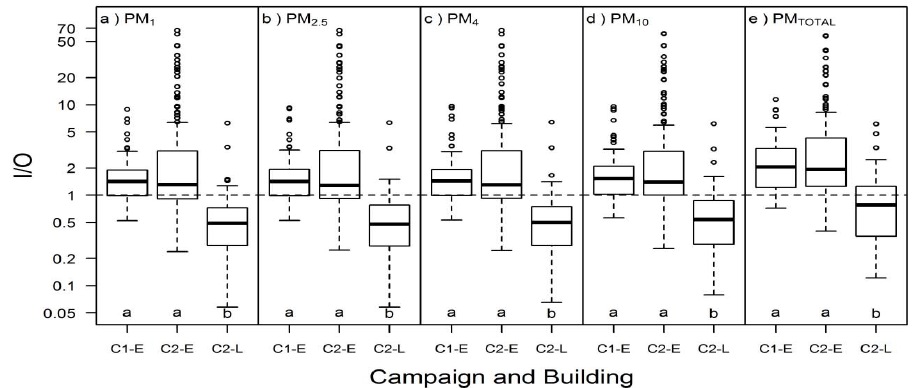
Figure 2. I/O in Campaign 1 Building E (C1-E; n = 55), Campaign 2 Building E (C2-E; n = 168), and Campaign 2 Building L (C2-L; n = 116) for ( a ) PM 1 ; ( b ) PM 2.5 ; ( c ) PM 4 ; ( d ) PM 10 ; and ( e ) PM TOTAL . Different letters within the same box represent statistically significant ( p < 0.05) groups under the Kruskal-Wallis multiple comparisons test. Dashed lines for equal indoor and outdoor concentrations (I/O = 1) are included for reference.